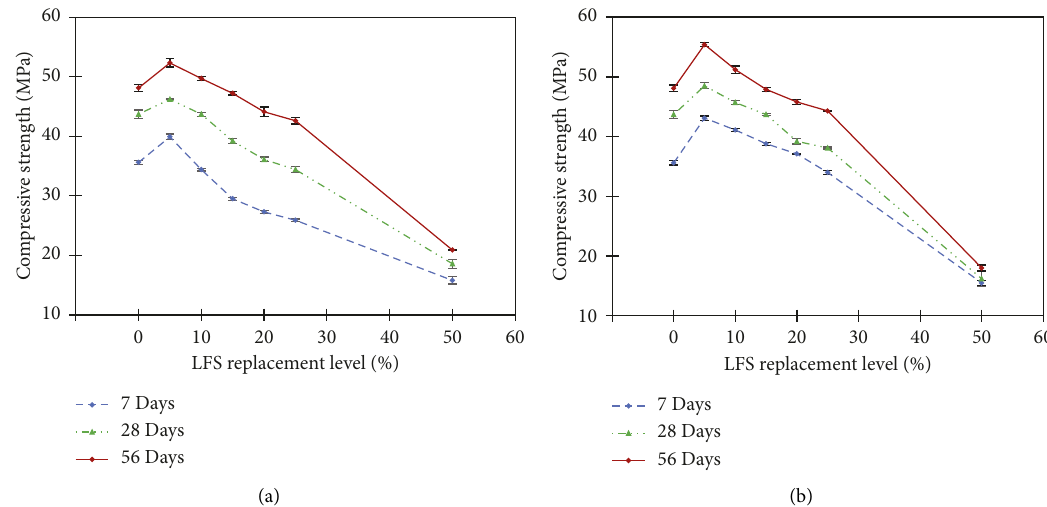
Figure 10: Relationship between compressive strength and LFS level in mortar: (a) mortar with raw LFS; (b) mortar with sieved